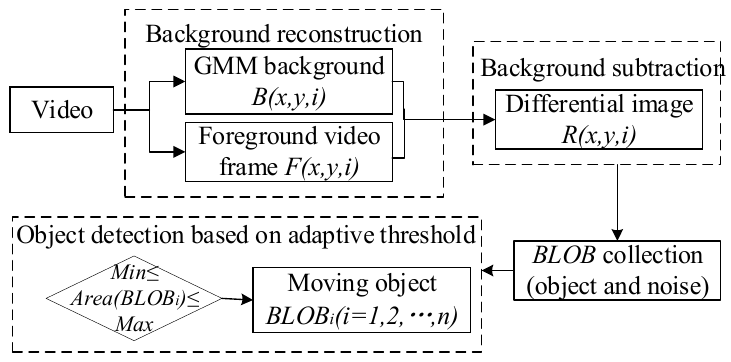
Figure 7. Dynamic target detection and BLOB moving object acquisition.